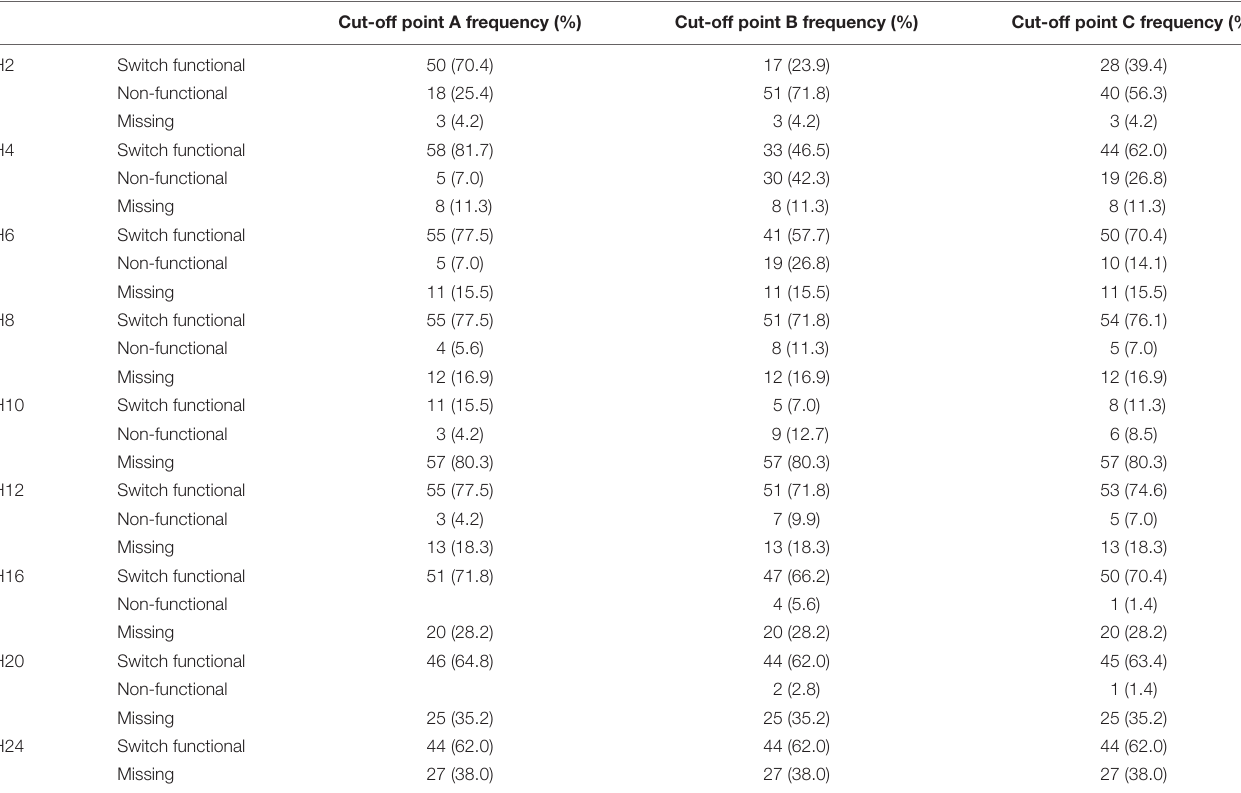
TABLE 3 | Frequency and percentage of switch to the functional population following the cut-off points A, B, and C. Cut-off point A frequency (%) Cut-off point B frequency